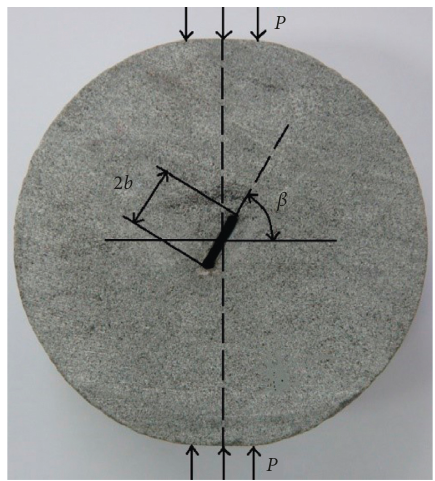
Figure 4: Schematic view of the fine sandstone CSCFBD